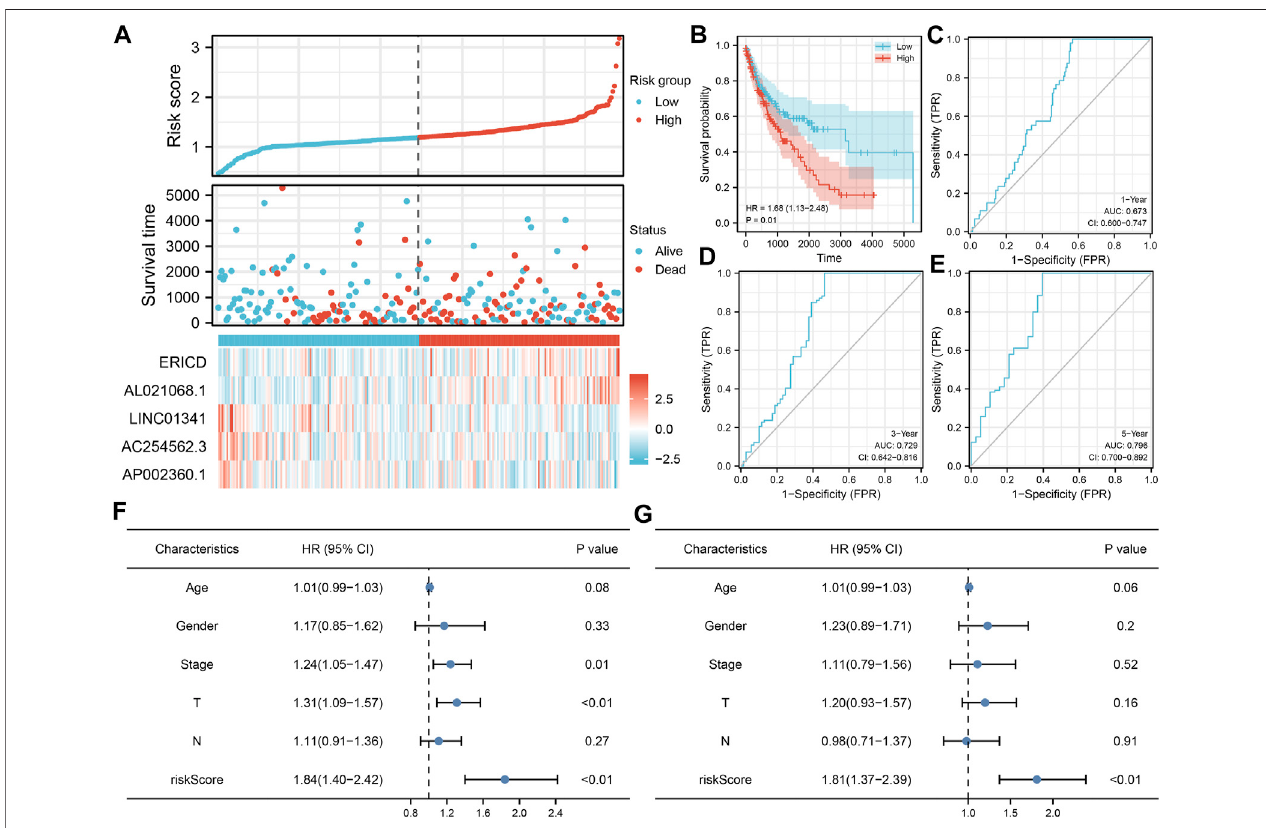
FIGURE 3 | Validation of the prognosis model. (A) Overview of our model in the validation cohort; (B – E) Kaplan – Meier survival and ROC curves in the validation cohorts; (F – G) Univariate and multivariate analysis of our model.